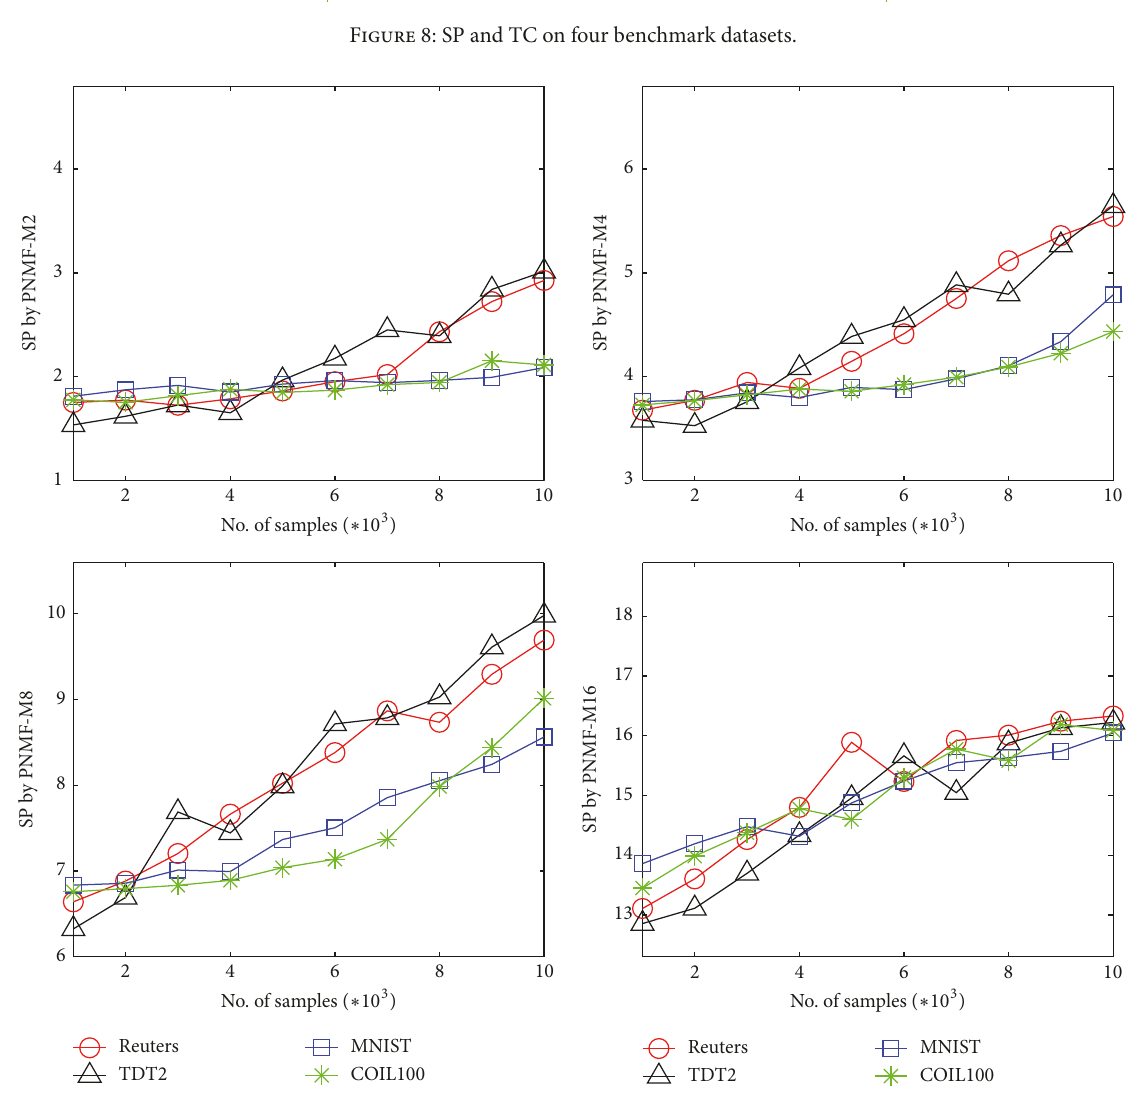
Figure 9: Speedup by PNMF-M on four benchmark